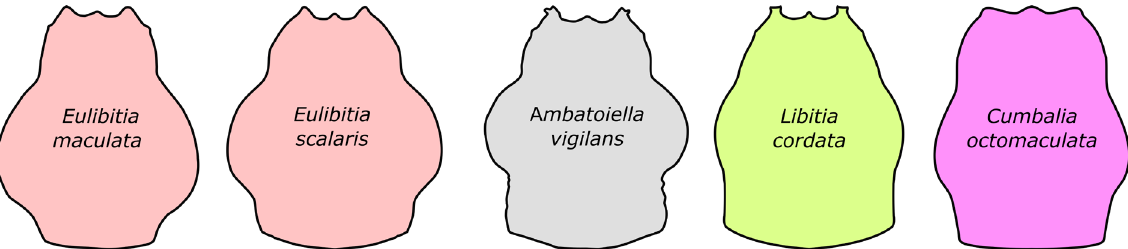
Fig. 1. Schematic outline of DS of Eulibitia Roewer, 1912 (beta), Ambatoiella Mello-Leitão, 1943 (alpha), Libitia Simon, 1879 (alpha) and Cumbalia Roewer, 1963